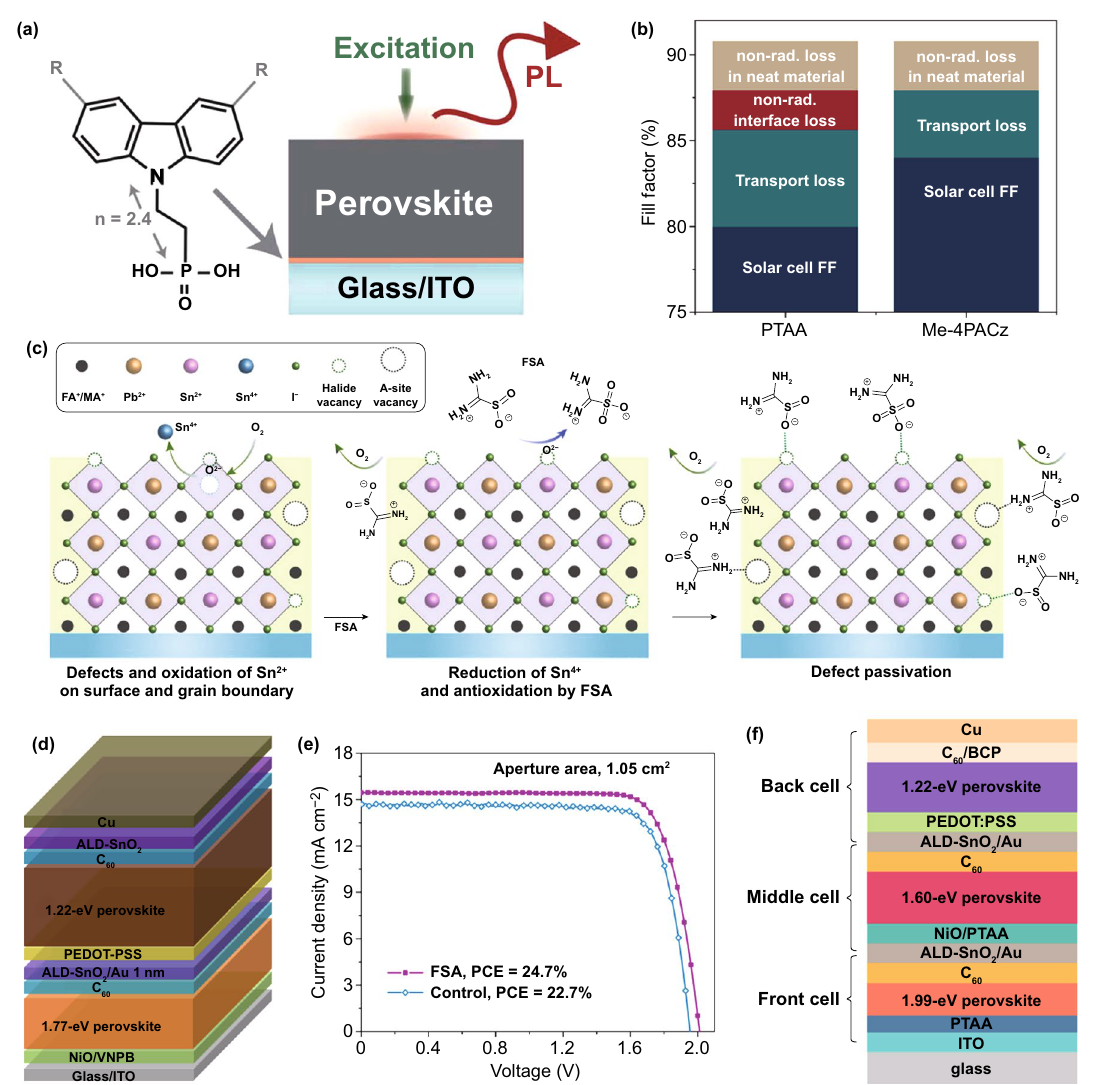
Fig. 6 a Schematic of the photoluminescence measurement and the chemical structure of carbazole-based HTL molecules, with R represent- ing a methyl group for Me-4PACz. The number of 4 denotes the number of carbon atoms between the phosphonic anchoring group and the carbazole unit for Me-4PACz. b The FF loss mechanisms for PTAA and Me-4PACz PSCs based on the detailed balance analysis. Reproduced with permission from Ref. [10] Copyright 2021 AAAS. c Schematic illustration of suppressing Sn 2+ oxidation and the passivation of halide and cation vacancy at the grain surface of mixed Sn–Pb perovskite films enabled by FSA molecule. A-site represents the organic monovalent cations in the lattice. d Structure of all-perovskite tandem device with 1.22 eV narrow-bandgap absorber and 1.77 eV wide-bandgap absorber. e J-V curves of the best control and FSA tandem devices with an aperture area of 1.05 cm 2 . Reproduced with permission from Ref. [9] Copyright 2020 Nature Publishing Group. f Device configuration of the all-perovskite triple-junction tandem device. Reproduced with permission from Ref. [65] Copyright 2020 American Chemical Society